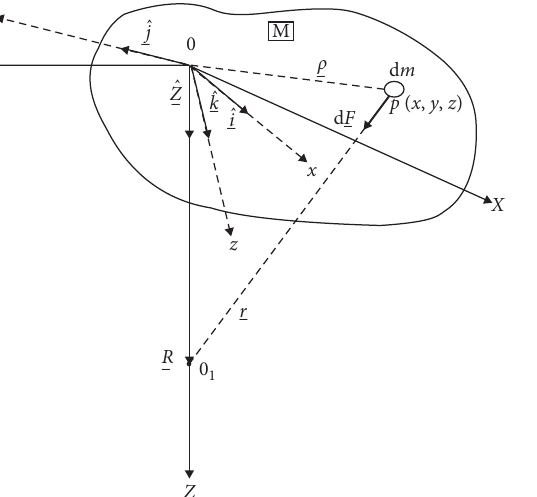
Figure 1: Description of motion in terms of moving and fixed